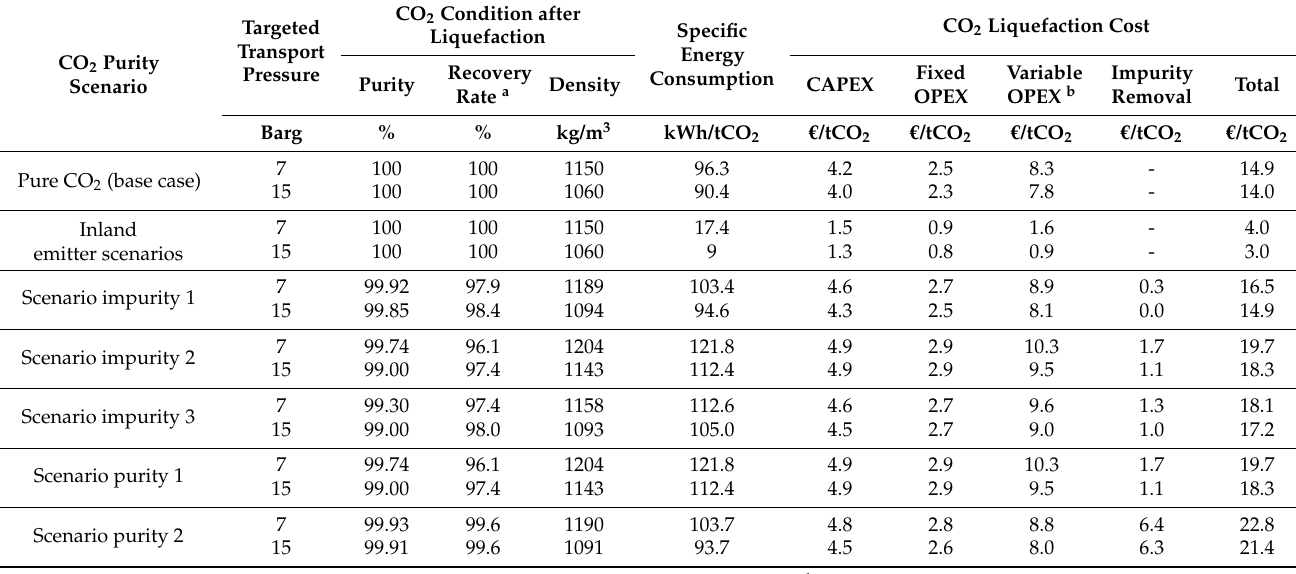
Table 3. Summary of the characteristics and costs of liquefying 1 MtCO 2 /year for the different CO 2 purity and impurity scenarios.